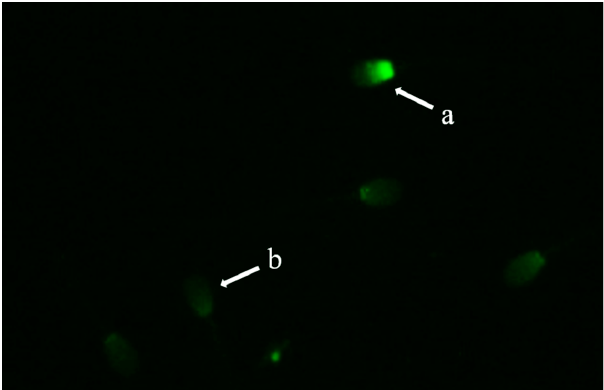
Figure 4. Chromomycin A 3 staining of sperm chromatin to indicate protamine-deficient (a) and normal sperm (b).